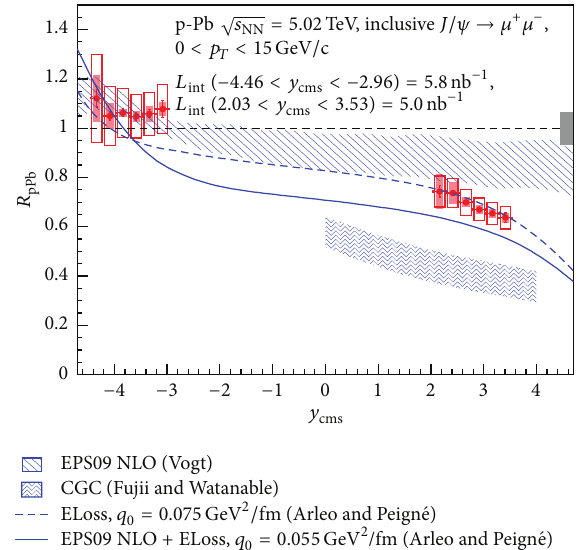
Figure 4: Comparison of ALICE 𝑅 pPb results for inclusive 𝐽/𝜓 with theoretical